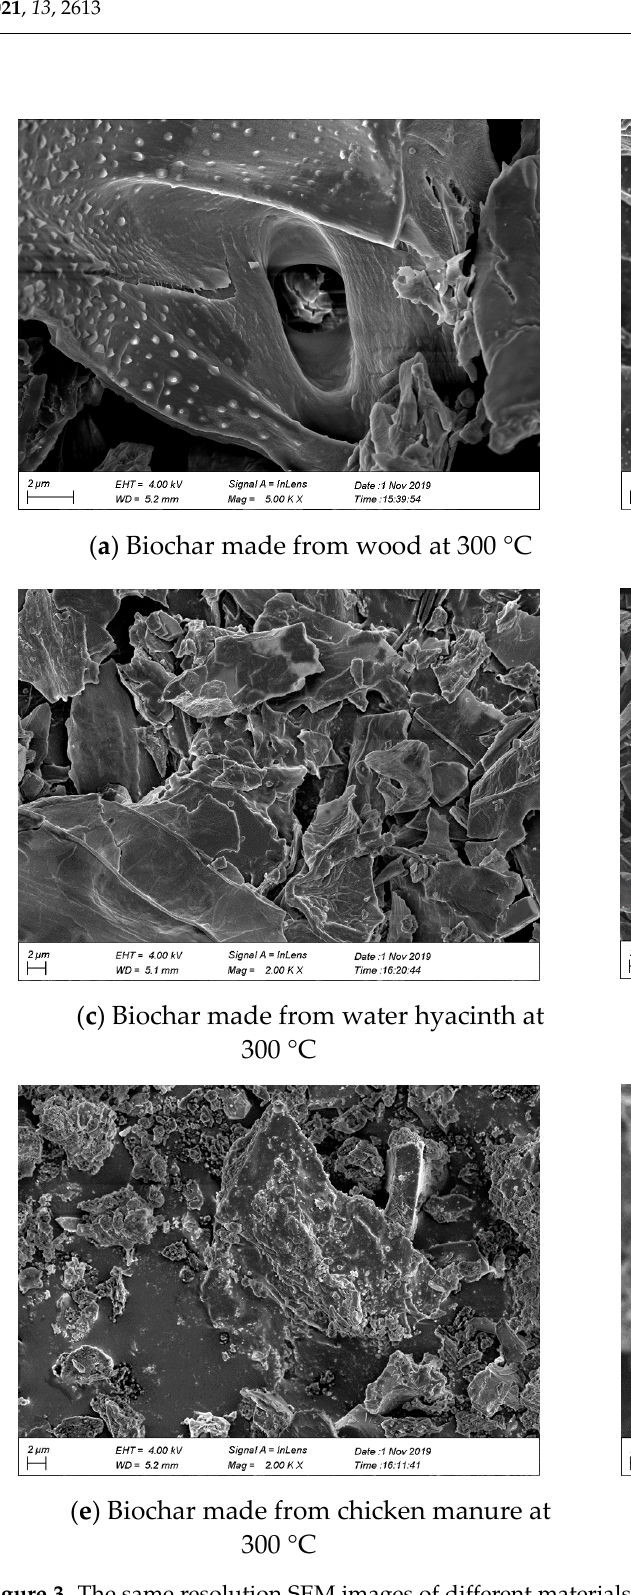
Figure 3. The same resolution SEM images of different materials that was pyrolyzed at 300 °C ( a , c , e ) and 600 °C ( b , d , f ). Comparing the SEM images of various biochars at different preparation temperatures, the porous structure of biochar gradually becomes obvious and tends to be broken with the increase of pyrolysis temperature.